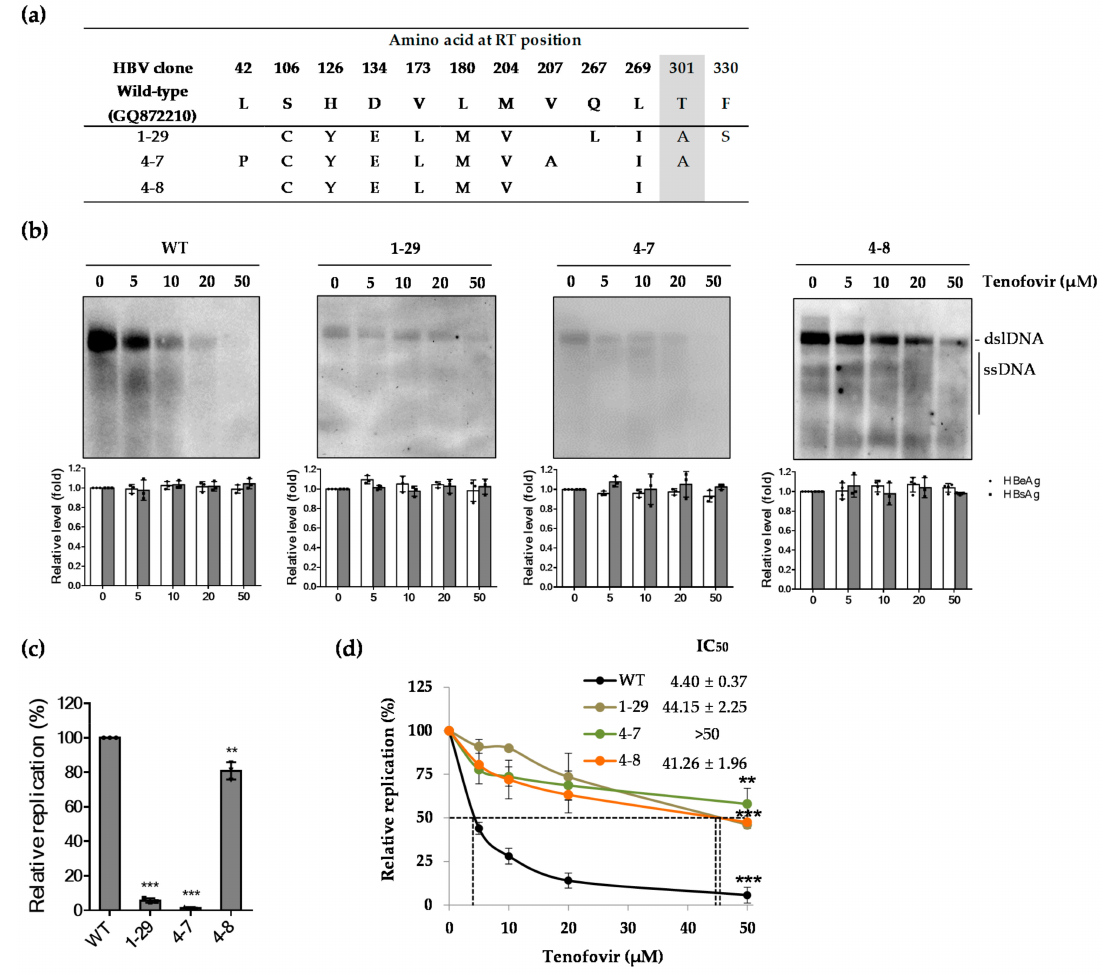
Figure 3. Effect of the naturally occurring rtT301A mutation on replication ability and tenofovir resistance in Huh7 cells. ( a ) Representative tenofovir-resistant clones (with or without the rtT301A mutation) obtained from the TDF-treated patient. ( b ) In vitro tenofovir susceptibility assay by Southern blot in Huh7 cells. The levels of secreted HBeAg and HBsAg were analyzed by ELISA. ( c ) The replication capacity of each clone was determined by quantitative real-time PCR, compared to that of WT. ** p < 0.01; *** p < 0.001. ( d ) IC 50 values were measured by quantitative real-time PCR. The level of HBV replication without drug treatment was set to 100%. ** p < 0.01; *** p < 0.001. Data in ( b – d ) were obtained from three independent experiments (mean ±